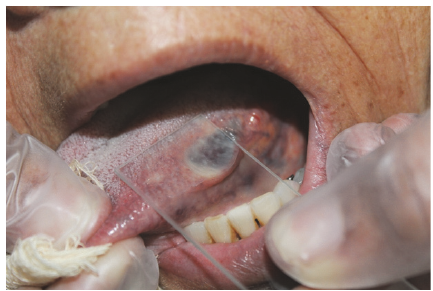
Figure 2: Diascopy (pressure on the lesion with a glass slide) showing color